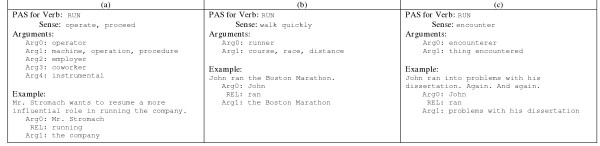
PropBank's three distinct predicate-argument structures of run. The figure shows examples of predicate-argument structures defined in PropBank [22, 23] project. PropBank defines different predicate-argument structures on account of verb sense variation. Three distinctive predicate-argument structures are defined for the verb run. A predicate-argument structure for each sense contains its own set of arguments labeled with semantic roles as shown in the figure.